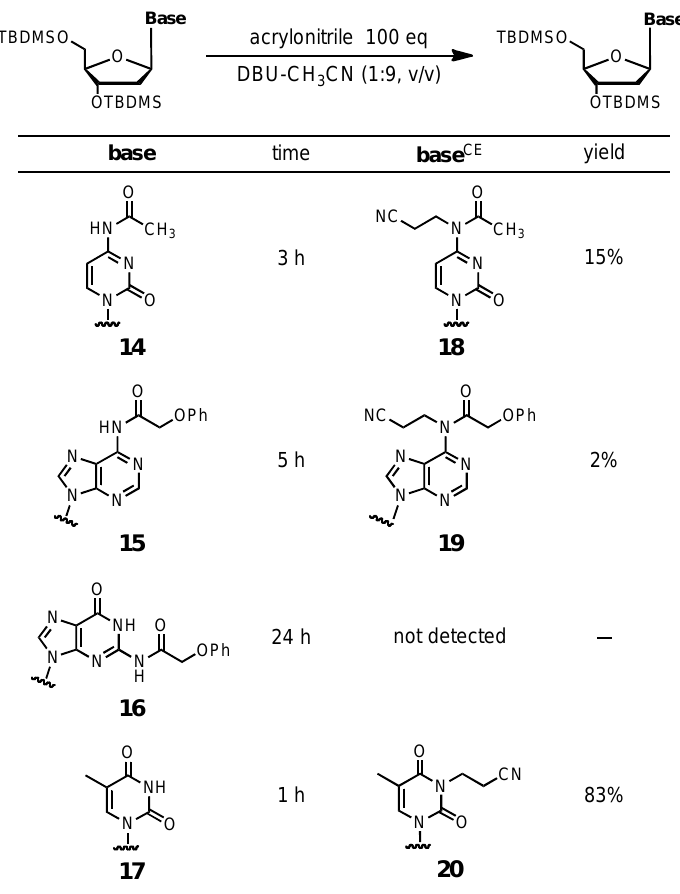
Table 1. Cyanoethylation of the common protected monomers in solution phase